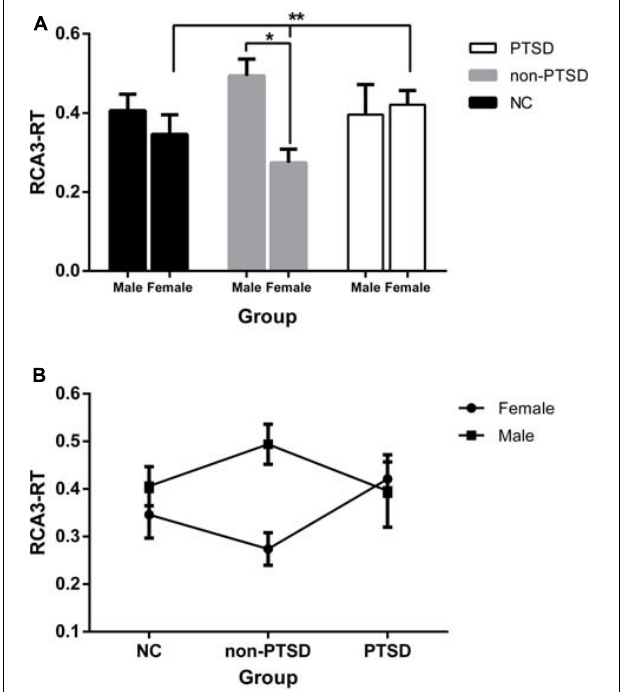
FIGURE 3 | Functional connectivity (FC) between the female and male within and among the groups adjusting for the effects of age and education levels. (A) Except the non-PTSD group (*), neither the NC nor the PTSD group, the RCA3-RT FC was not significantly different between the male and female. Additionally, in the female participants, the RCA3-RT FC was significantly different among the NC, non-PTSD, and PTSD groups (**); (B) the dynamic changes in the three groups in the male or female. RCA3-RT, right hippocampal CA3 and the right thalamus; CA, Cornu Ammonis; PTSD, post-traumatic stress disorder; NC, normal control; *, ** P <